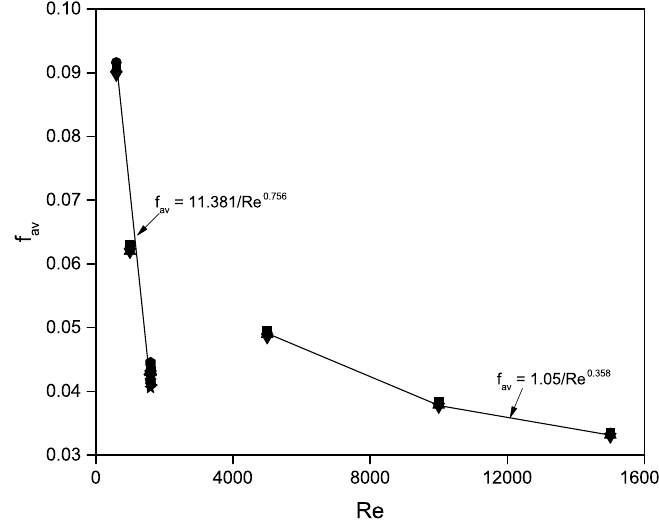
Figure 16. Influence of the Reynolds number Re on the average friction coefficient f av . Results obtained for all values of ϕ , d np and all types of